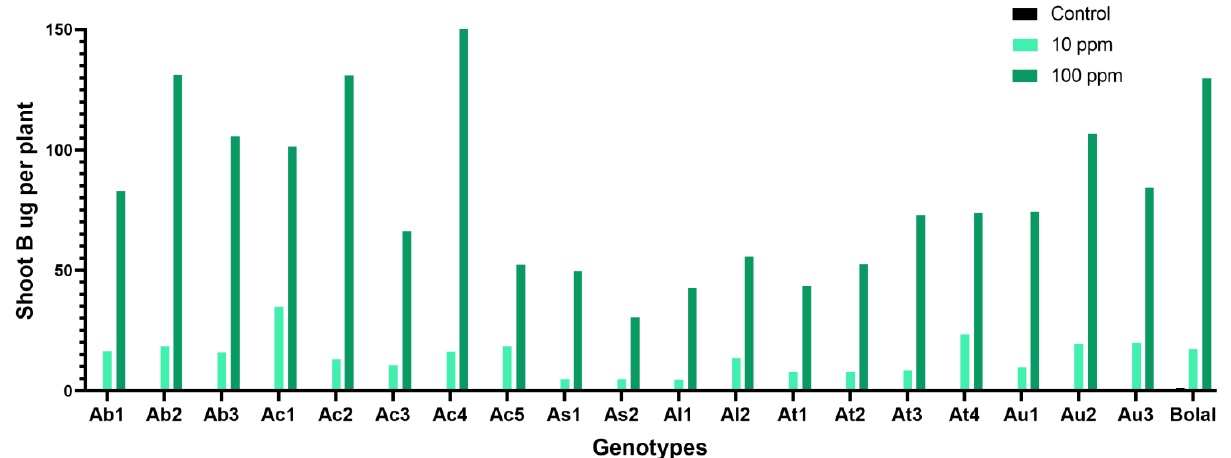
Figure 7. Variation in the RB (root boron) and SB (shoot boron) of 19 Aegilops genotypes and the B tolerant check cultivar, Bolal 2973, in Control (3.1 µ M B), toxic B (10 ppm B), and highly toxic B (100 ppm B).